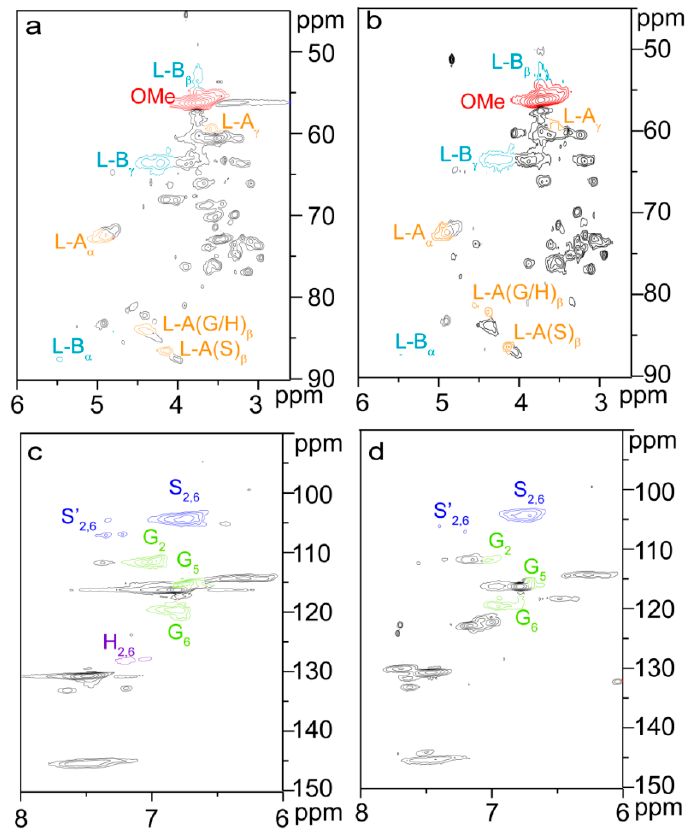
Figure 7. 2D HSQC NMR spectra of unmodified (L0, a , c ) and esterified (L5, b , d ) lignin.